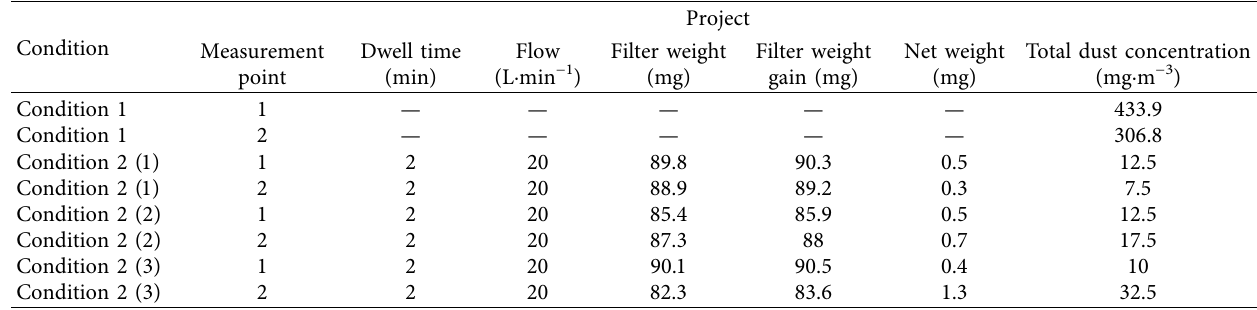
Table 2: Total dust sampling concentration.